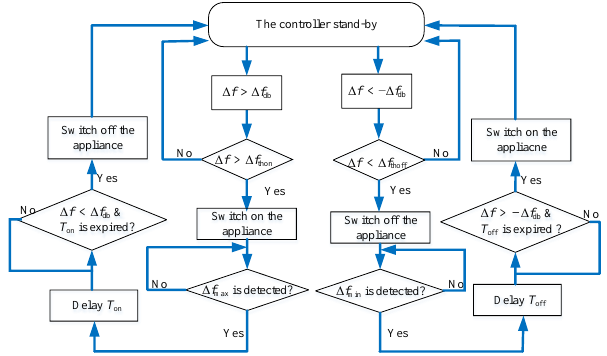
Figure 4. The control logic of the individual controller.